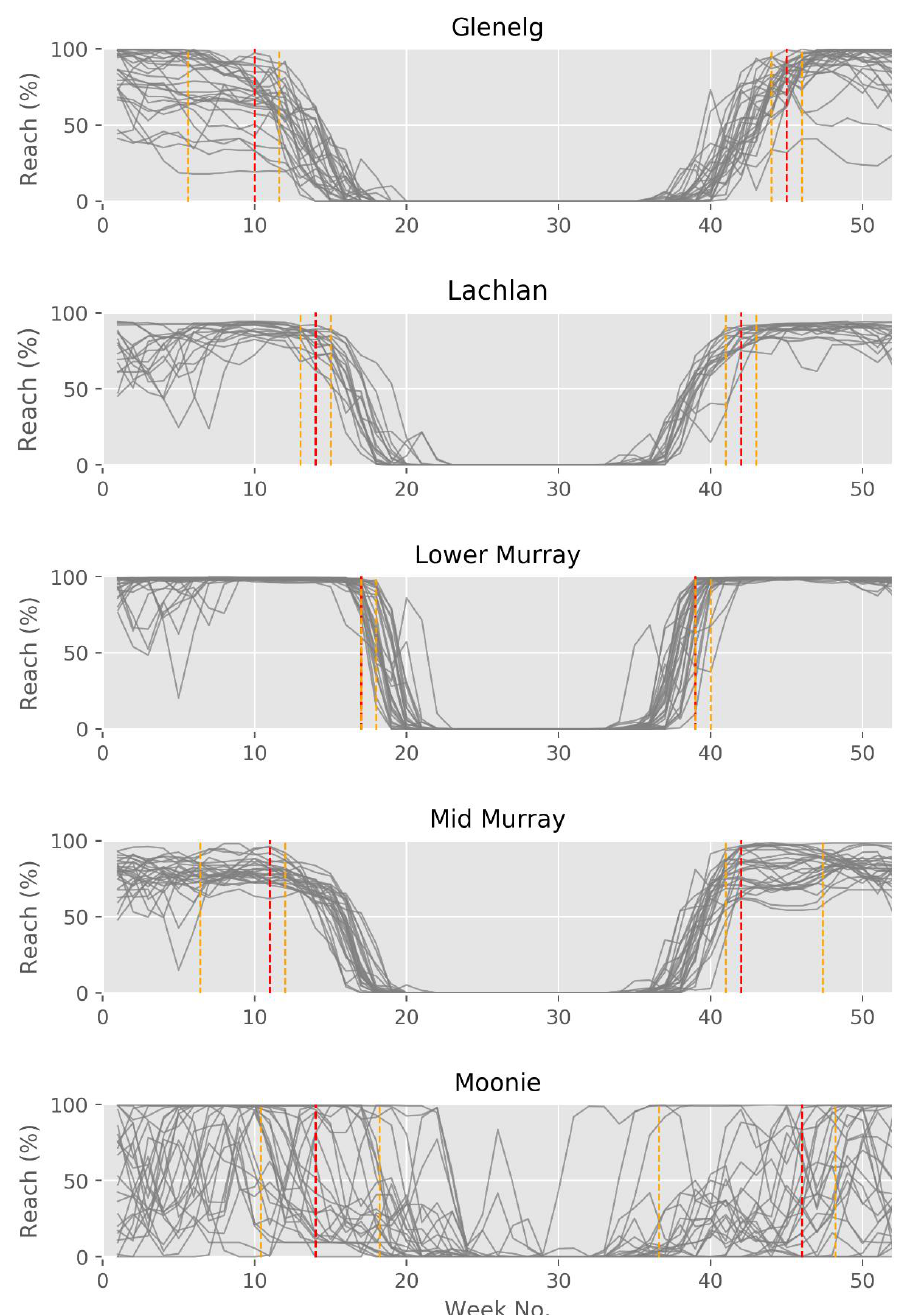
Figure 7. Annual cycles of the number of reaches within the permissible temperature range for virus activity. Each line represents a single year. Red lines within the winter-summer period indicate the median first week over the entire time series where 80% of reaches are within the optimal permissive range, and during the summer-winter period, the red line represents the last week where 80% of reaches are within the optimal permissive range. Orange lines represent the 20th and 80th percentiles for both spring and summer. For values see Table 6.